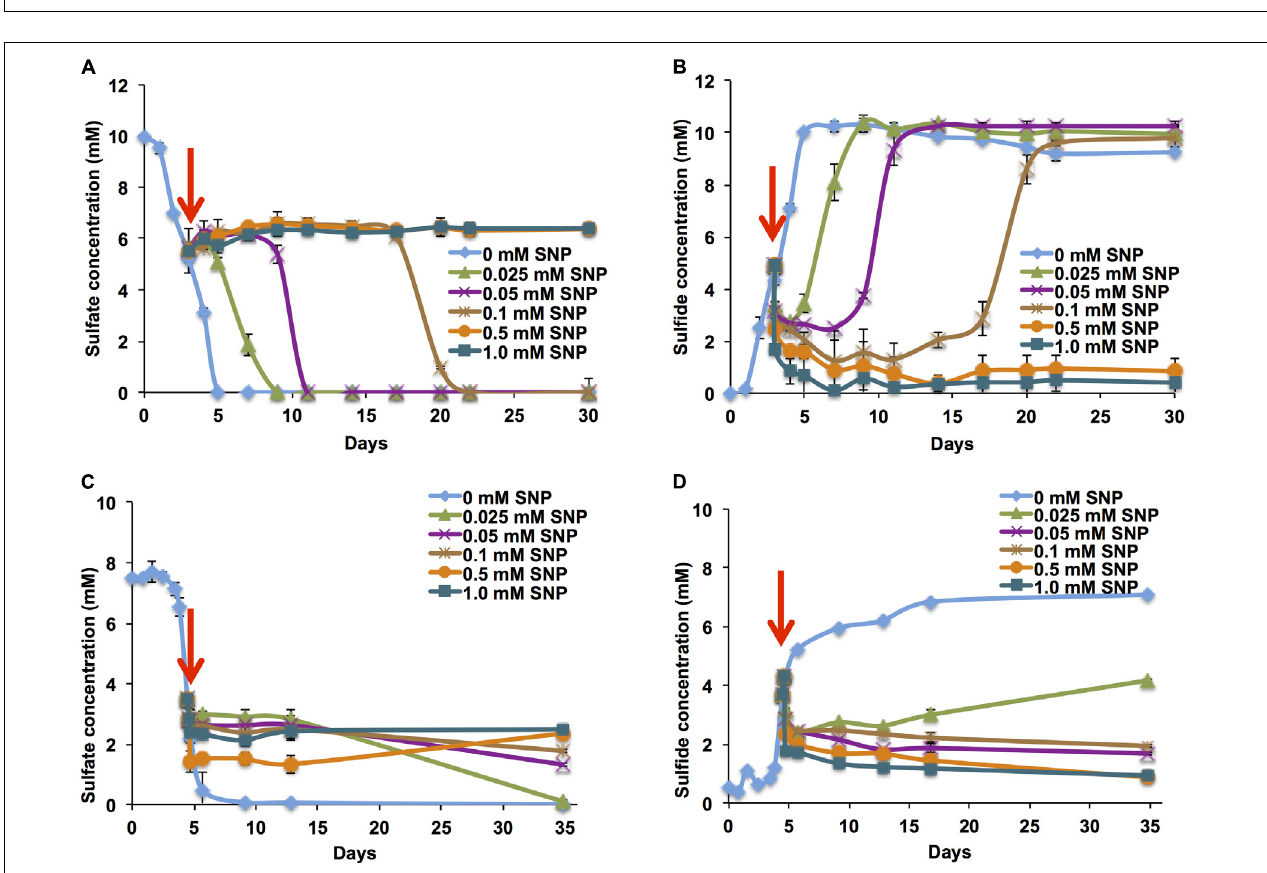
FIGURE 2 | Sulfate consumption and sulfide production by mSRB and tSRB consortia grown at 30 and 60 ◦ C, respectively, in the presence of SNP. Sulfate consumption by mSRB (A) , sulfide production by mSRB (B) , sulfate consumption by tSRB (C) , and sulfide production by tSRB (D) of consortia grown in minimal medium in the presence of different concentrations of SNP added to the culture at the mid-log phase of growth ( ↓